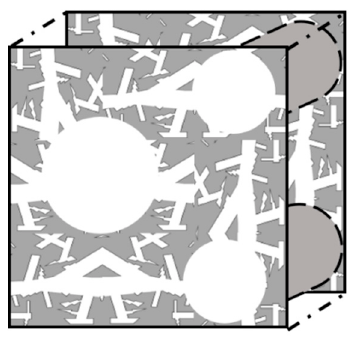
Figure 5. An analysis model for the theory of nanopores, showing a model that combines the theory of a structure made of cylinders and micropores [25,39,40,42,45,48].